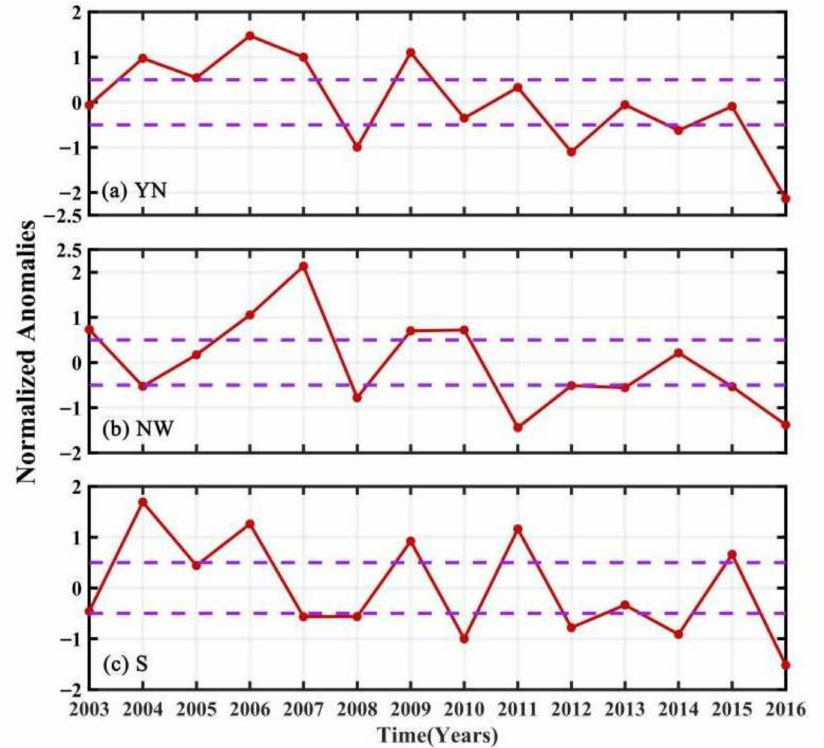
Figure 7. The temporal evolution of annual burned area normalized anomalies (red solid line) for the period of 2003–2016 in Yunnan ( a ), region NW ( b ) and S ( c ). The purple dashed line denotes the ± 0.5 standard deviation. The normalized anomalies mean that the time series of burned area was